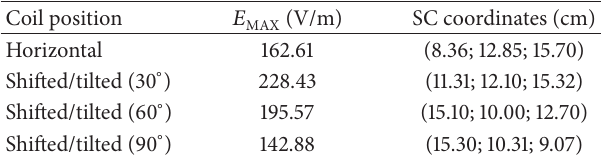
⃗𝐸| Figure 5: | (V/m) distributions calculated with the admittance method using a homogeneous brain model 3 mm of resolution for the horizontal MAG-9925-00 coil on the top surface (a) and on a coronal section at 𝑦 = 10.9 cm (e), the shifted and rotated (30 ∘ ) MAG-9925-00 coil on the top surface (b) and on a coronal section at 𝑦 = 10.9 cm (f), the shifted and rotated (60 ∘ ) MAG-9925-00 coil on the top surface (c) and on a coronal section at 𝑦 = 10.9 cm (g), and the shifted and rotated (90 ∘ ) MAG-9925-00 coil on the top surface (d) and on a coronal section at 𝑦 = 10.9 cm (h). The white crosses are the projections of calculated SCs on the maps. ⃗𝐸| Table 2: Maximum | ( 𝐸 ) and stimulation center (SC) coordi- MAX natescalculatedfortheMAG-9925-00coilinfourdifferentpositions with respect to the